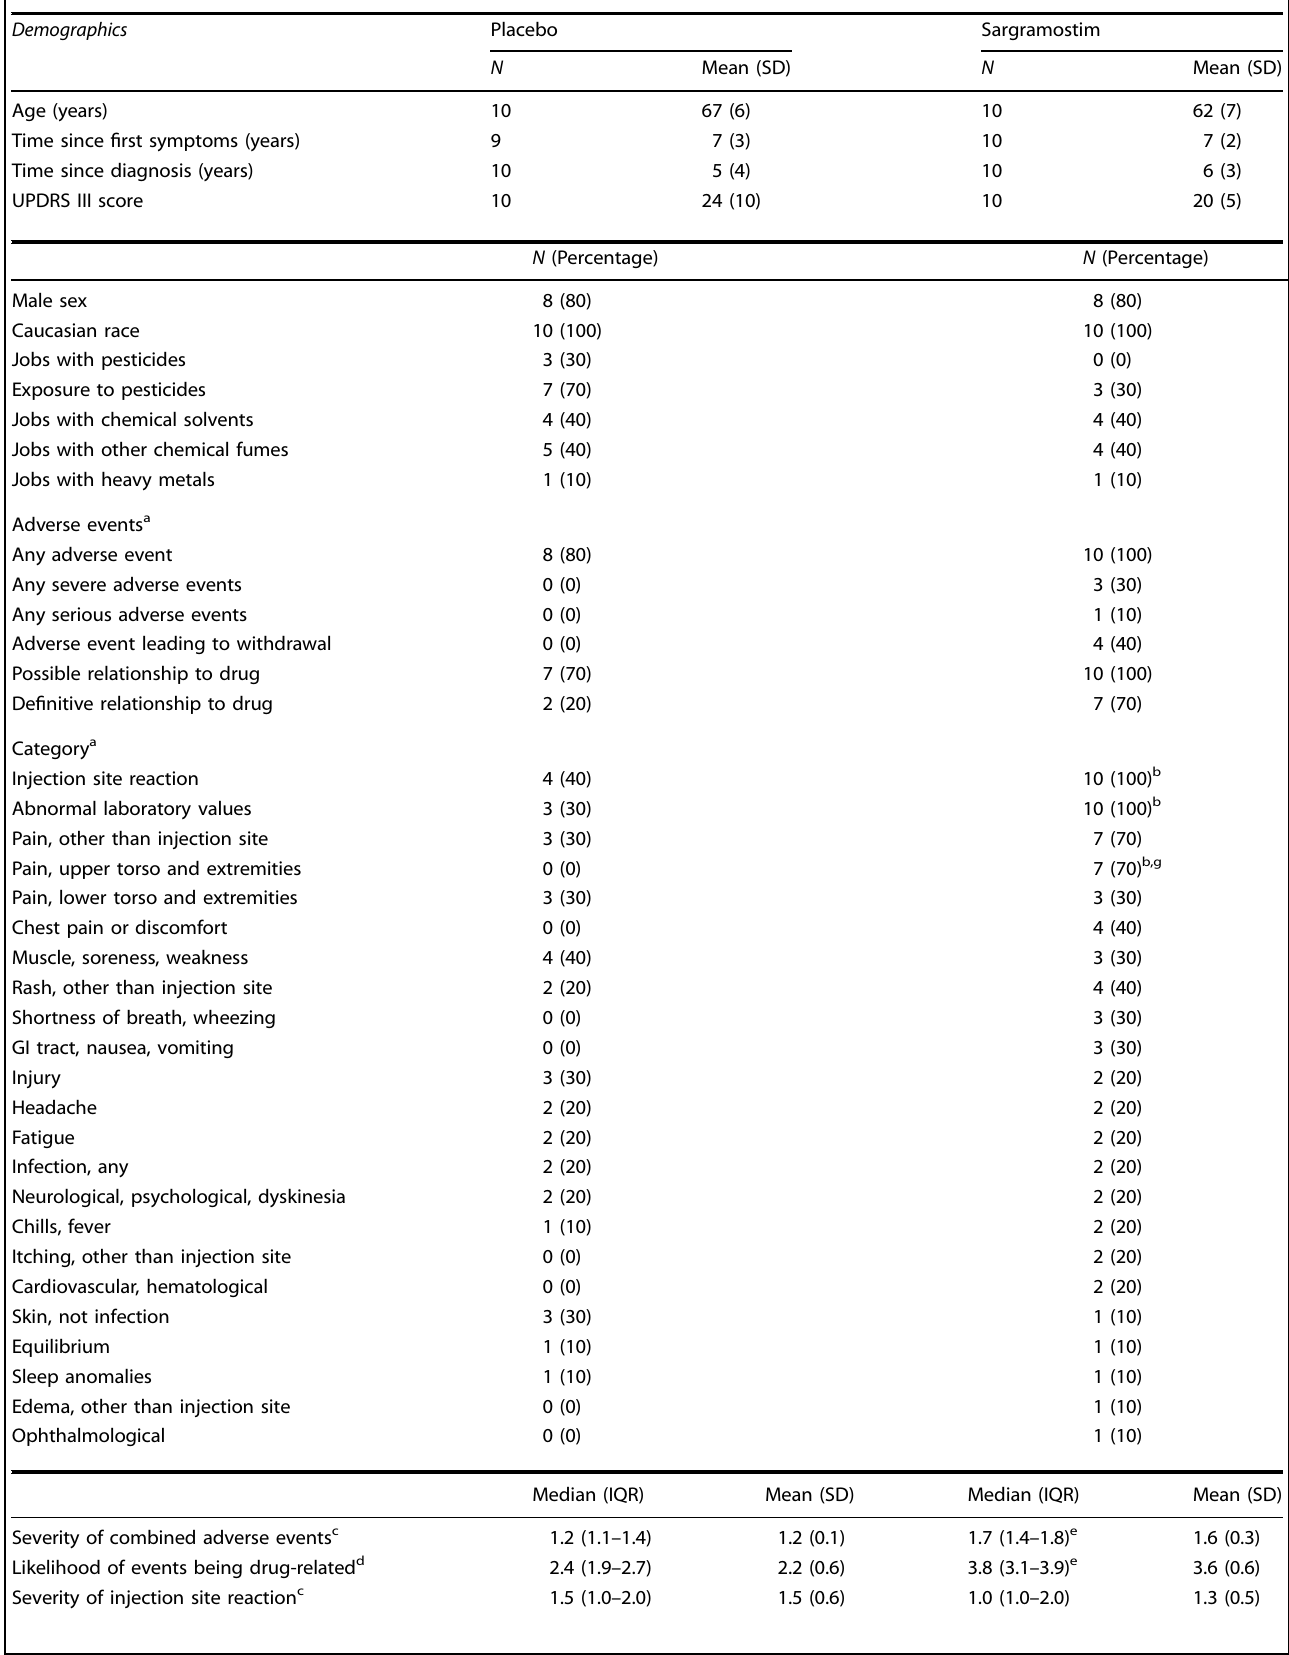
Table 2. Demographics and adverse events for PD patients